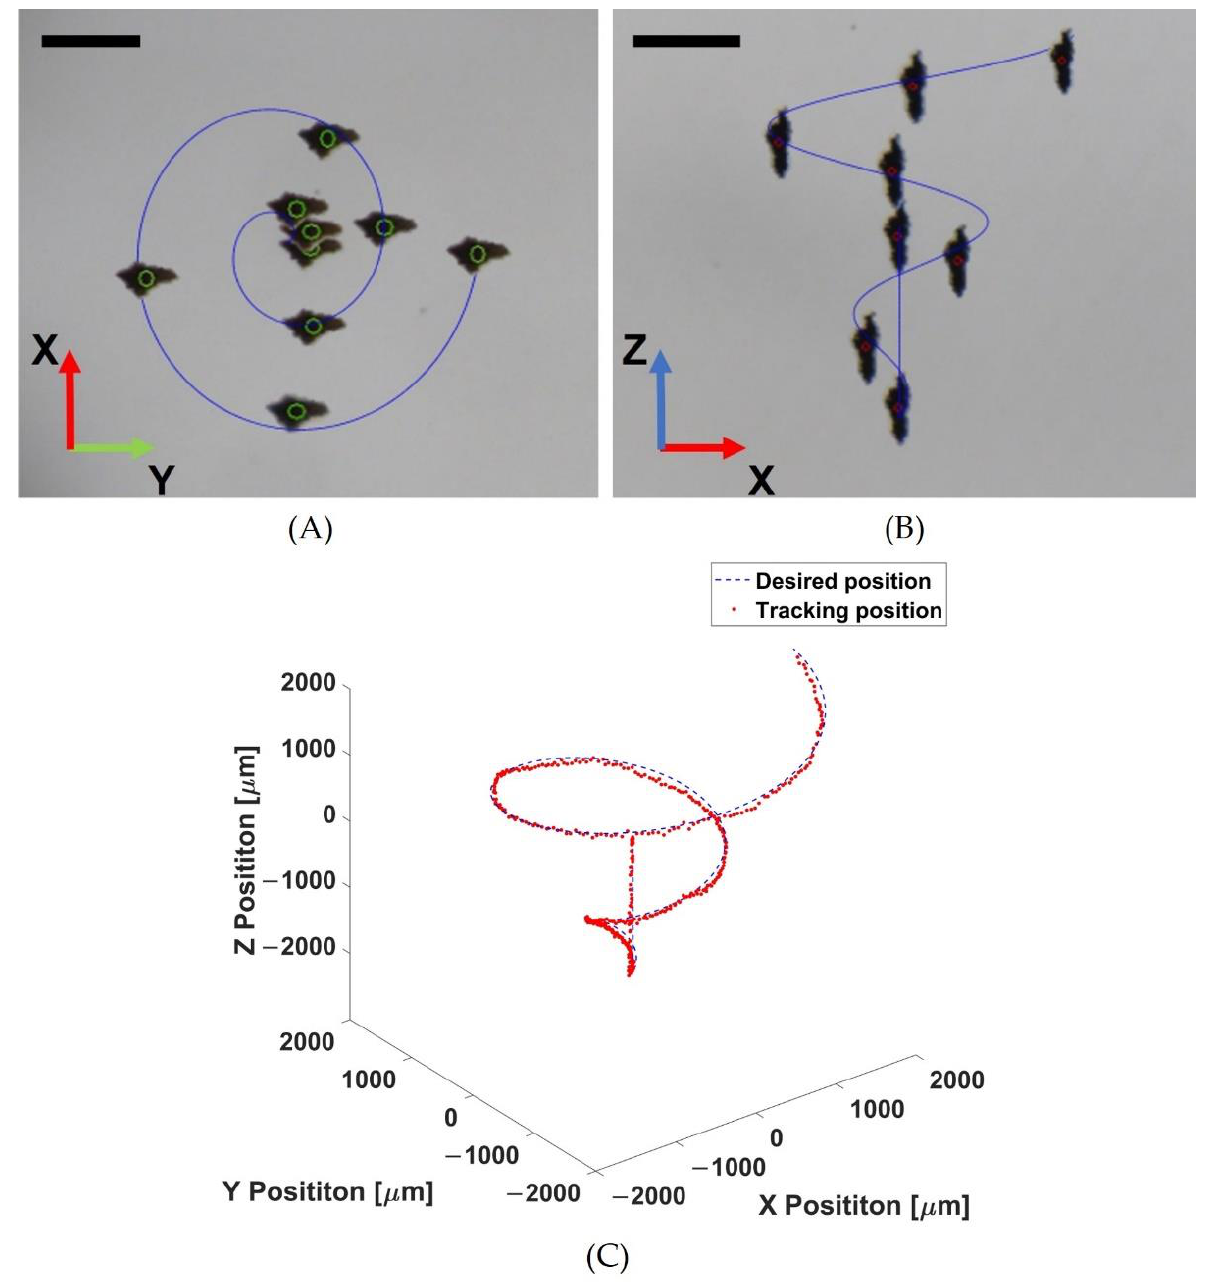
Figure 7. Demonstration of automated manipulation of Macbots following helical trajectory: ( A ) time-lapse image sequence in O-XY view; ( B ) time-lapse image sequence in O-XZ view; ( C ) position tracking denoted by red colored dots corresponding to the desired position denoted by the blue colored line (scale bar: 1 mm).